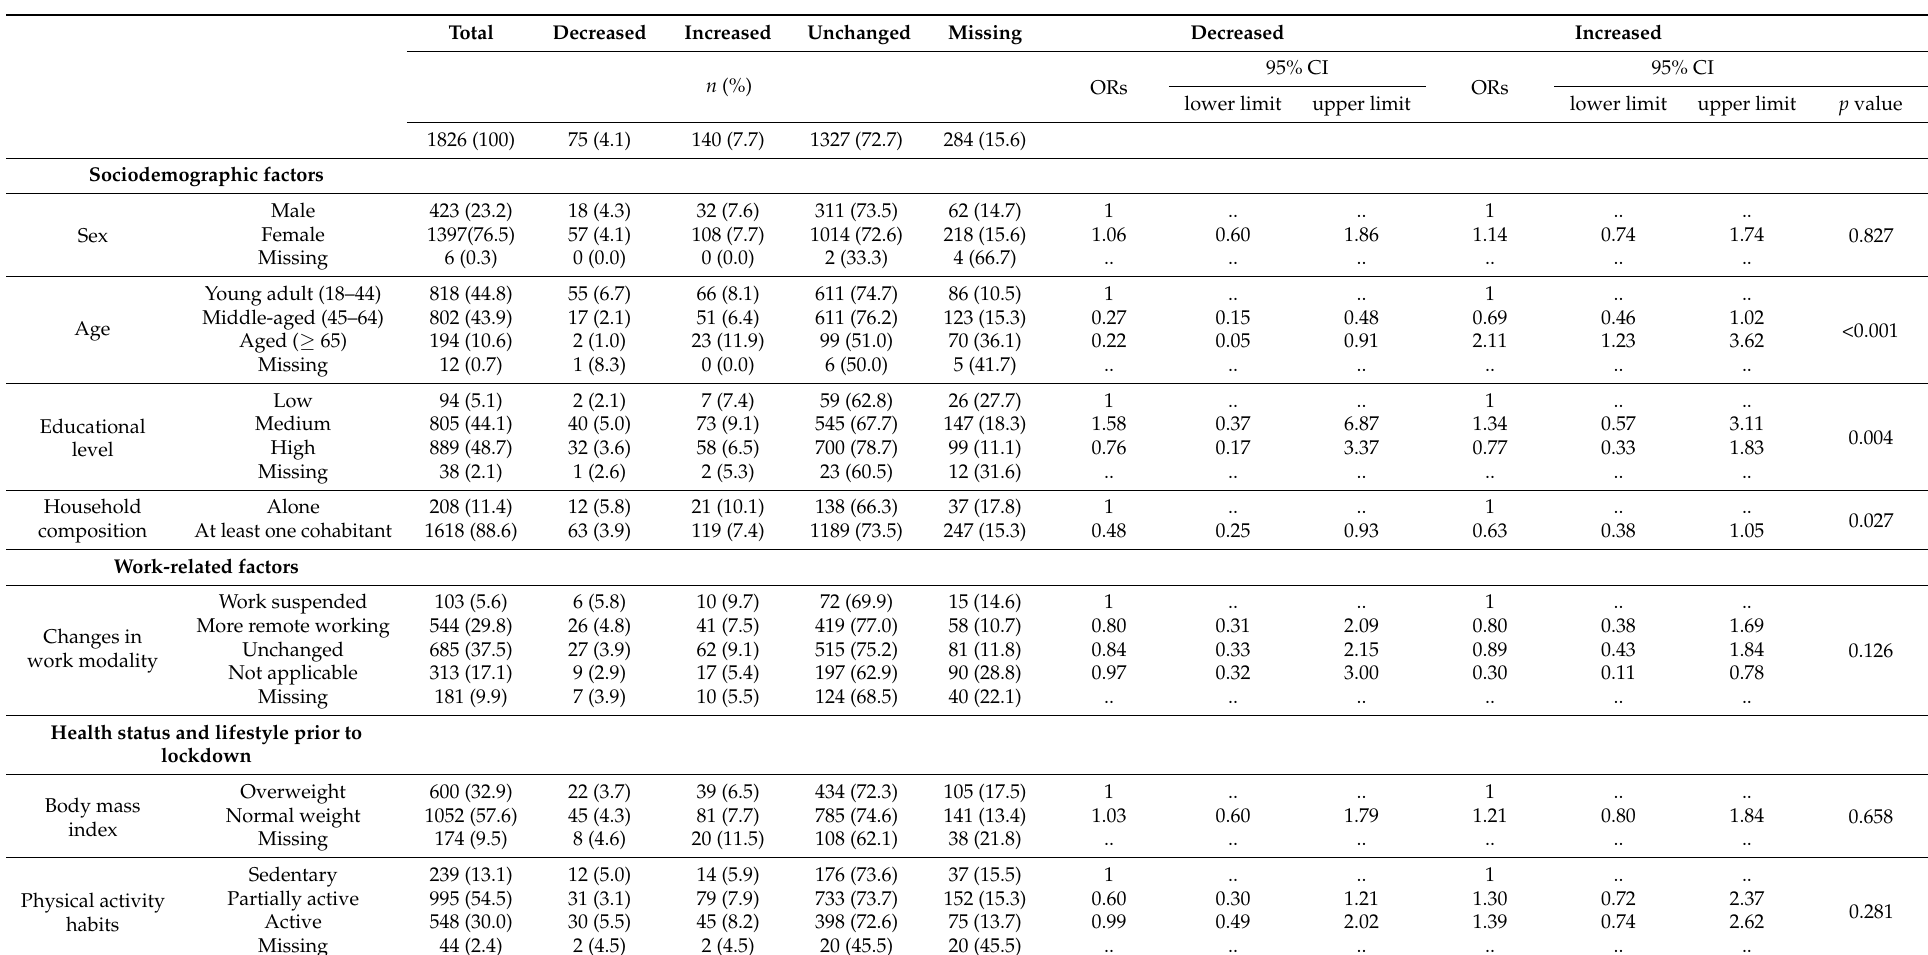
Table 5. Odds ratio for type of change in cigarette smoking (decreased, increased, or unchanged) during COVID-19 lockdown by sociodemographic and work-related factors, health status, and lifestyle prior to lockdown, and psychological